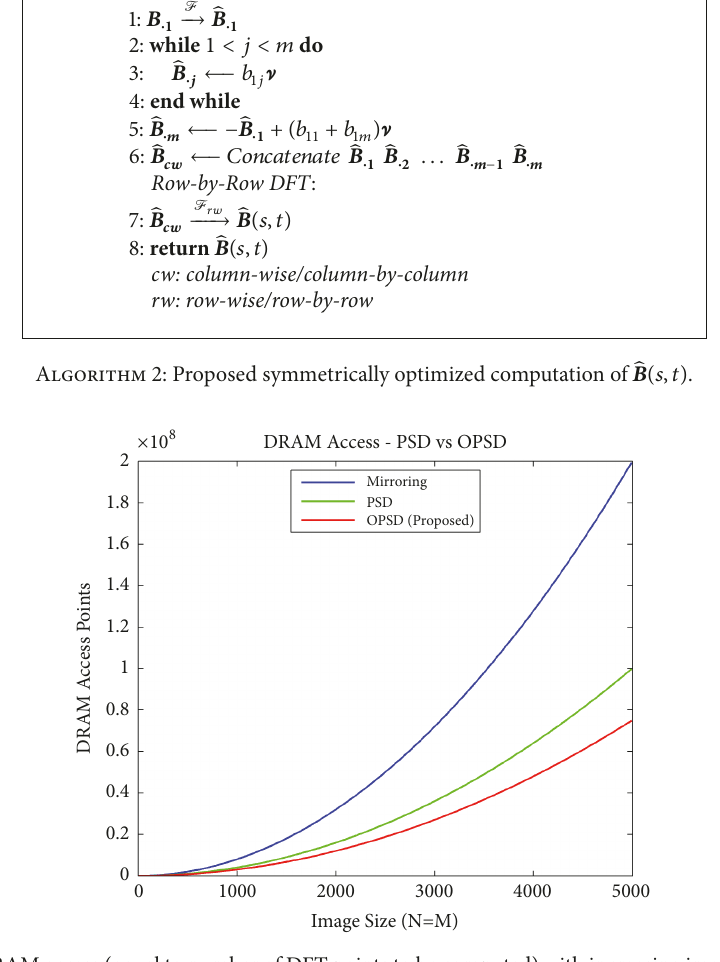
Figure 5: Graph showing DRAM access (equal to number of DFT points to be computed) with increasing image size for mirroring, periodic plus smooth decomposition (PSD), and our proposed optimized period plus smooth decomposition